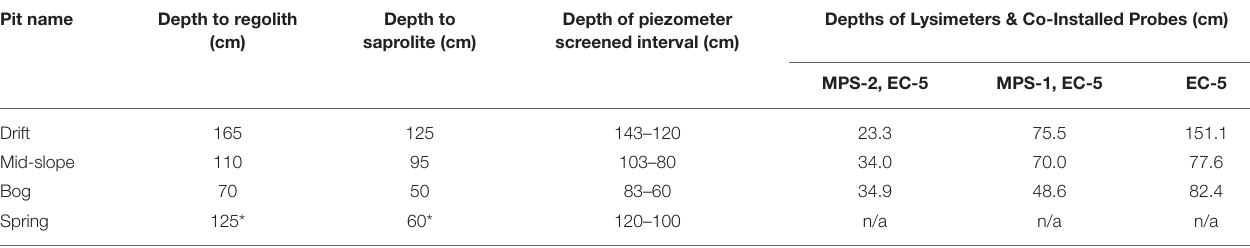
TABLE 1 | Depths of soil contacts and instrument installation for each soil